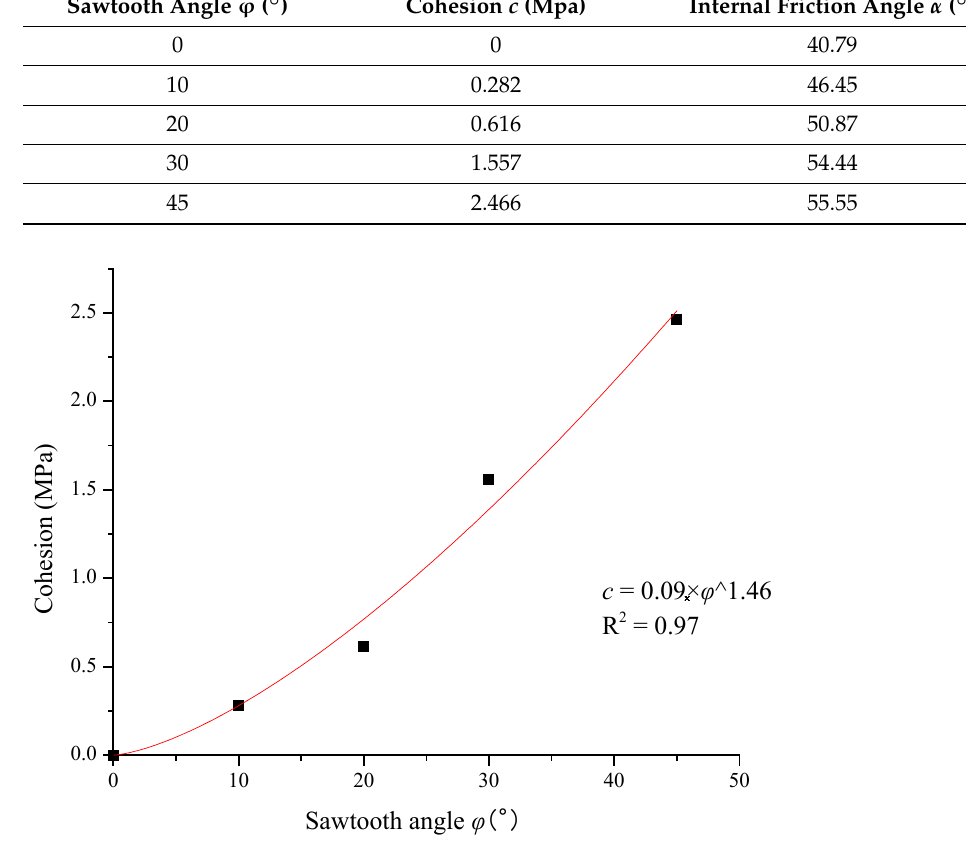
Figure 5. Relationship between cohesion and sawtooth angle.